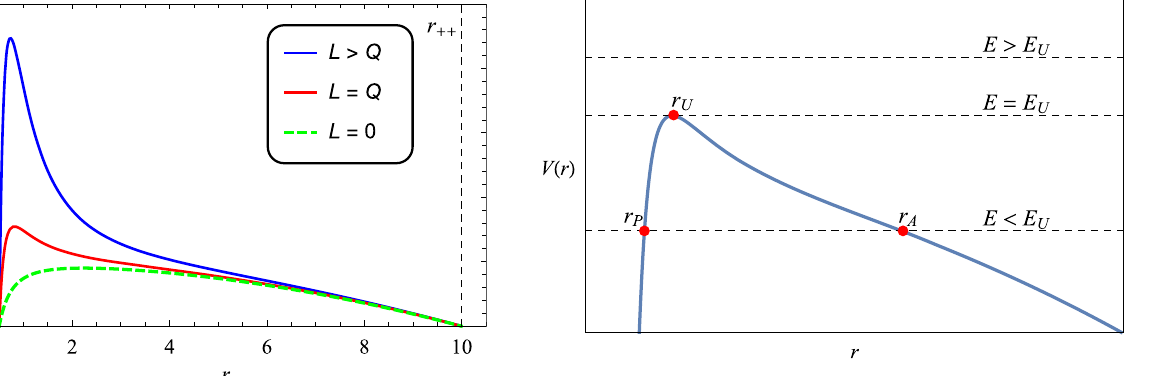
Fig. 1 The effective potential of the charged Weyl black hole, plotted for with λ = 10 and Q = 1, specified for particles with different designations of angular momentum. The larger the angular momentum, the more unstable is the potential’s apex. The values of the horizons correspond to r + (cid:8) 0 . 5 and r ++ (cid:8) 10